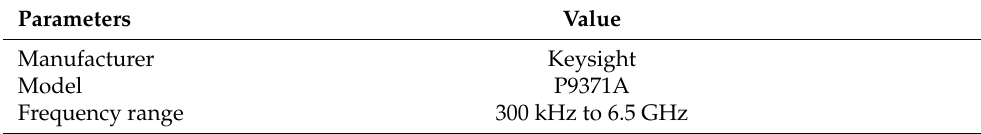
Table 3. Vector network analyzer parameters.